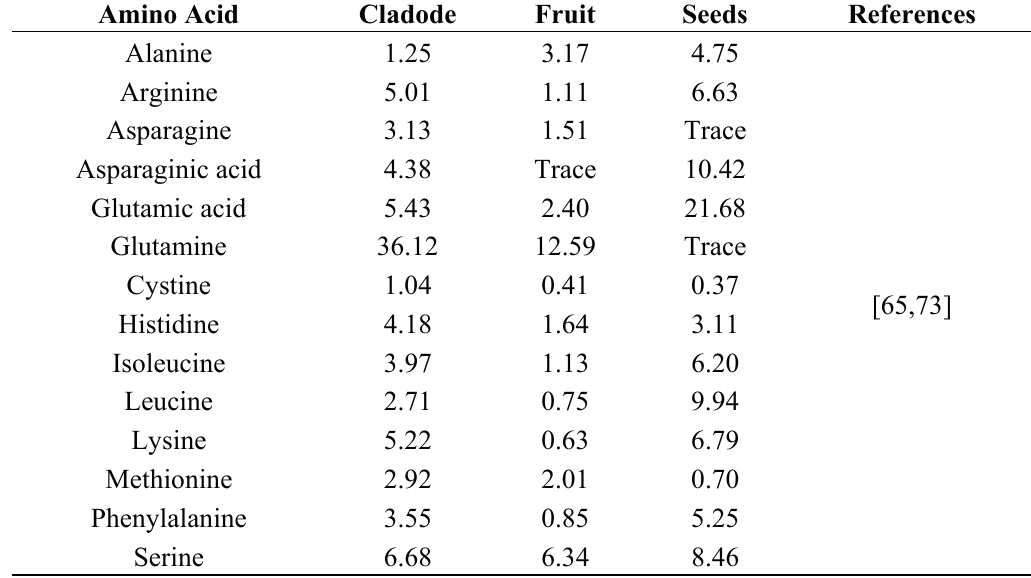
Table 6. Distribution and contents of amino acids content in seeds, cladode and fruit juice from O. ficus-indica . Amino acid contents are expressed as g/100